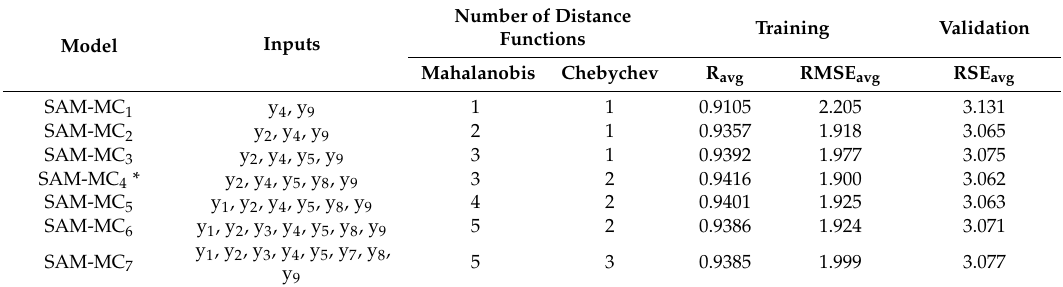
Table 4. Select kNN-based stacking ensemble models using multiple-type distance functions.